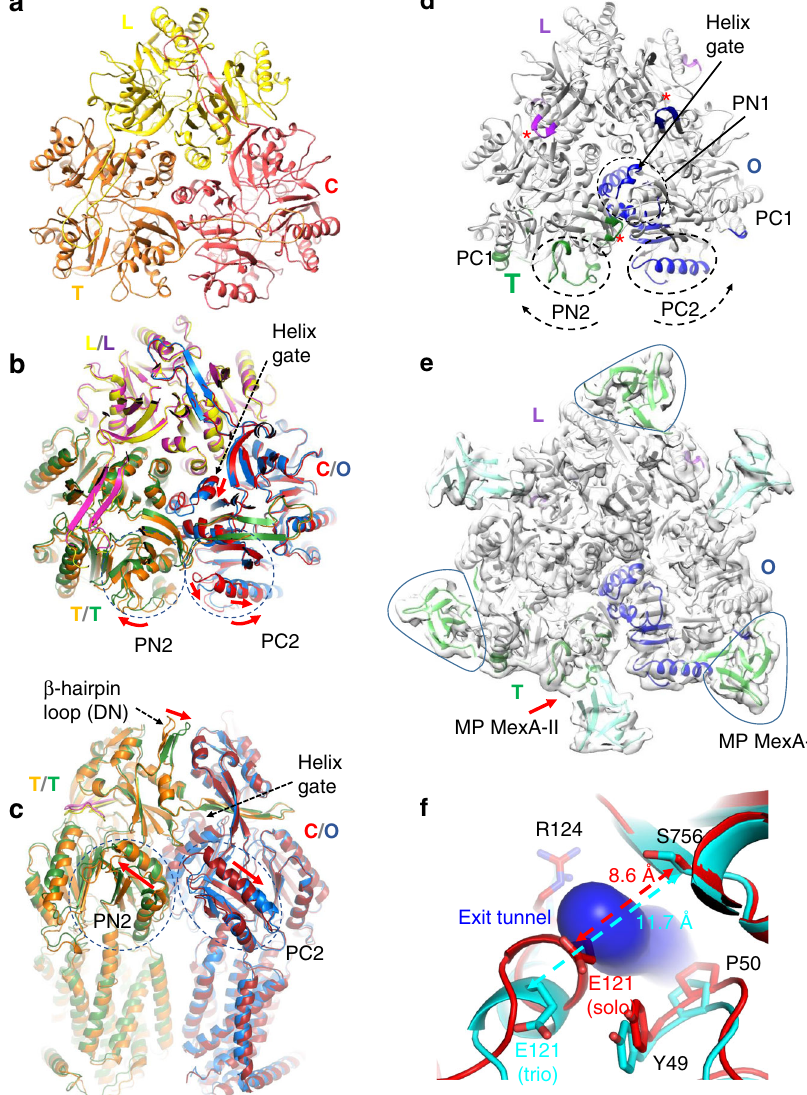
Fig. 2 Structure of MexB-solo and MexB-trio. a Pore domain visualization of MexB-solo trimer in LTC conformation shown in yellow, orange and red for the L, T, and C protomers respectively. b , c Superimposition of MexB-solo and MexB-trio (purple, green, and blue for the L, T, and O protomers respectively) viewed from the top ( b ) as in a and perpendicular to the membrane ( c ). In the periplasmic part, main conformational changes observed between MexB-solo and MexB-trio occurred in the three β -hairpin loops (DN domain) ( c ), in the T protomer PN2 domain, and in the neighboring protomer switched from C to O state with a combined movement of the PC2 domain and the central helix plus helix gate (PN1 domain). The described movements are illustrated by red arrows. d Pore domain visualization of MexB-trio trimer. The conformational changes observed in b – c between MexB-solo and MexB-trio are shown in purple, green and blue (for the L, T, and O protomers respectively), according to the root mean square deviations. Parts of the structure with rmsd lower than 2Å are in gray. The PN2 and PC2 shifts toward their respective PC1 domain are indicated by curved dashed black arrows. Note the colored β -hairpin loops illustrating their conformational changes (red asterisks). e Surface representation of tripartite complex at the level of pore domain of MexB. The three MP domains of MexA-I are contoured. The red arrow indicates the MP domain in contact with the portion of T protomer undergoing the large rmsd corresponding to the “ green ” segments shown in d . MexA-I and MexA-II models are shown in light-green and cyan, respectively. f View of the exit gate delineated by the helix gate E121-R124 on the left and the β strand on the right in protomer C of MexB-solo (red) and in protomer O of MexB-trio (cyan). The helix in protomer O of MexB-trio moves away forming a passage for drug exit that is hampered in protomer C of MexB-solo as shown with the tunnel (blue) calculated using